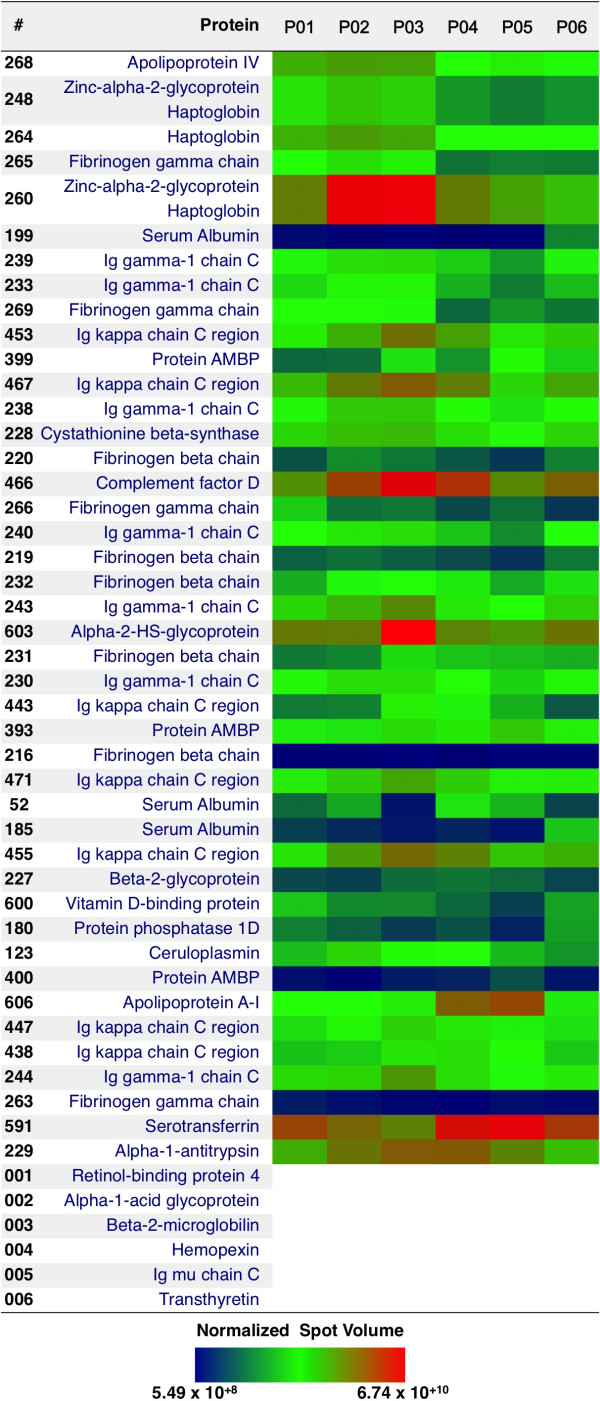
Comparative level of protein abundance in peritoneal dialysate effluent.